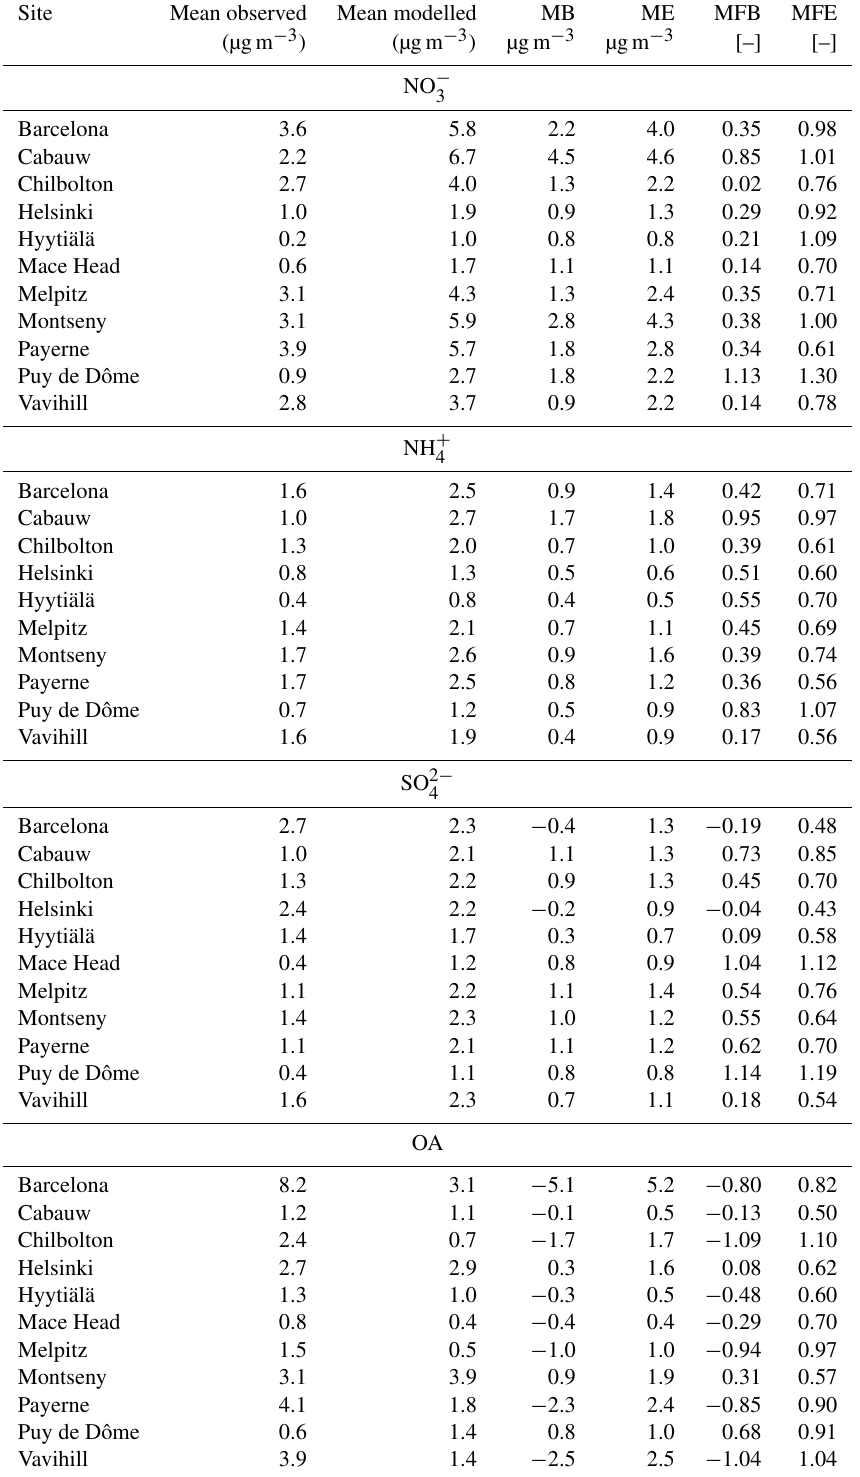
Table 3. Statistical analysis of nitrate, ammonium, sulfate and organic aerosol for the base case (VBS_BC) for February–March 2009 at different AMS